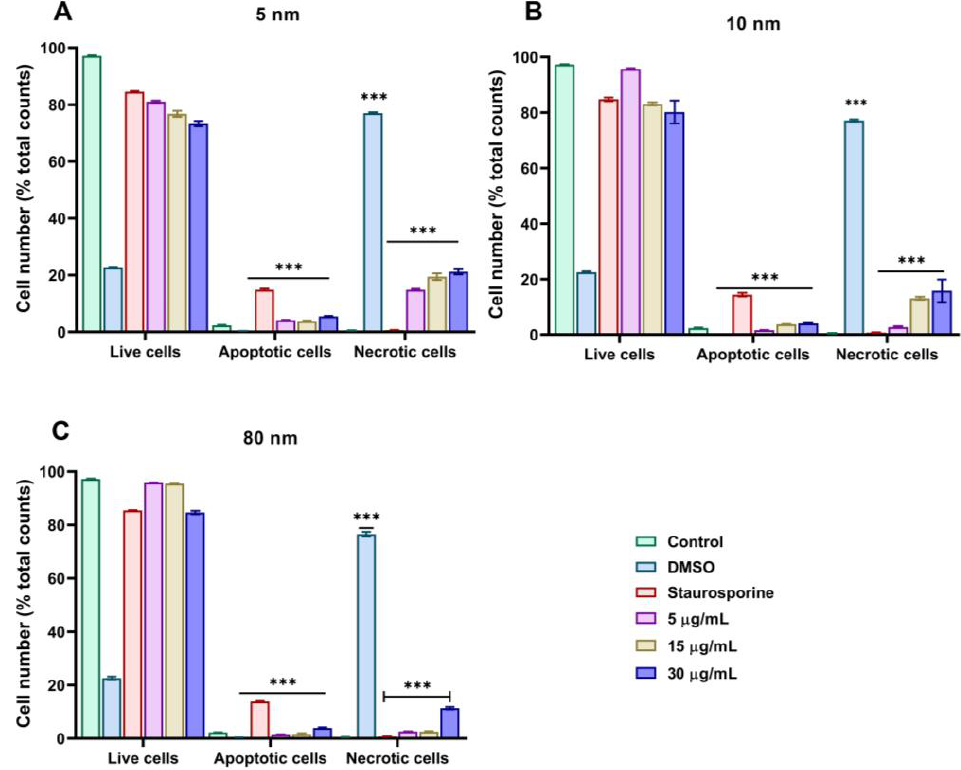
Figure 6. Bar graph analyses of apoptosis and necrosis assessed by flow cytometry after the incubation of A549 cells with ( A ) 5 nm, ( B ) 10 nm, and ( C ) 80 nm AuNPs at concentrations of 5 – 30 µg/mL. Treatment with 1 µM of staurosporine and 10% DMSO for 6 h were used as positive controls for apoptosis and necrosis, respectively. Plotted graphs represent the means ± SD of three independent experiments. Bars with an asterisk (*) show a statistical difference (*** p < 0.001) when compared with the control.